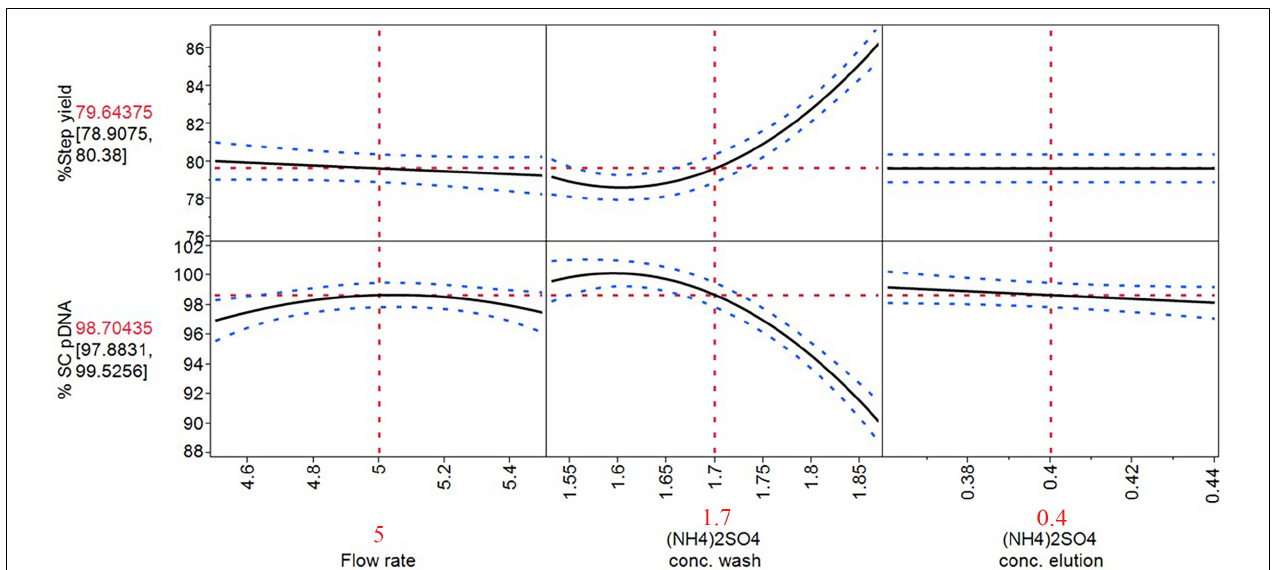
FIGURE 5 | Prediction profiler of optimized process on HIC purification step. The solid lines are the predicted model. The red dashed lines are the interaction plots and the blue dashed lines are the confidence interval.